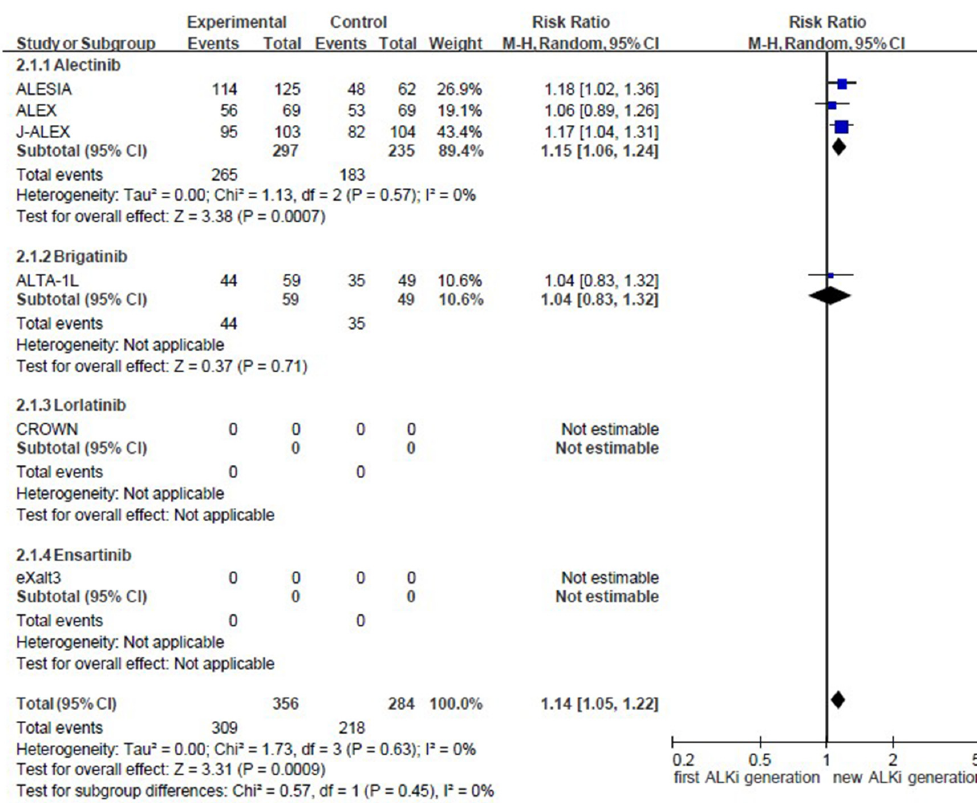
Figure A3. Forest plot and pooled response ratio for objective response rate (ORR).